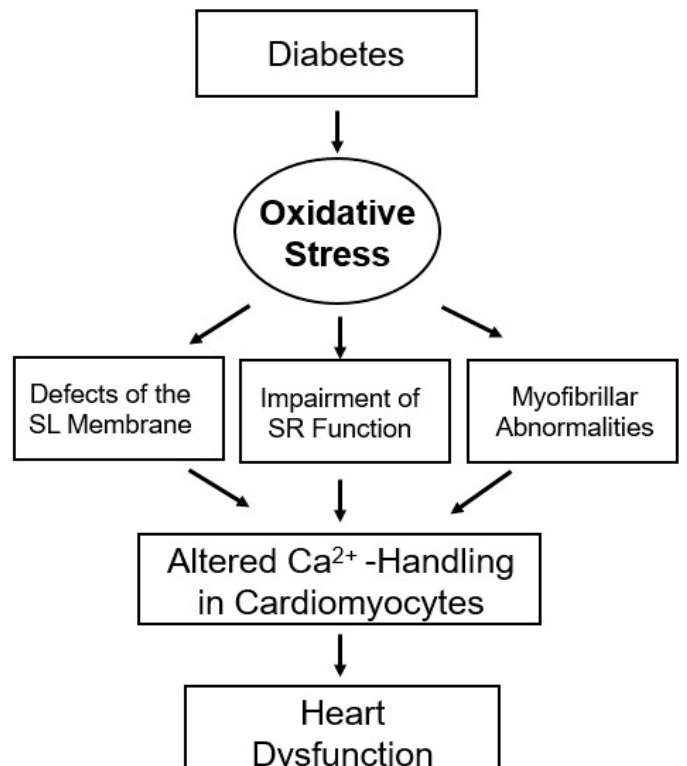
Figure 2. Role of oxidative stress in subcellular remodeling and Ca 2+ -handling abnormalities in the diabetic heart.